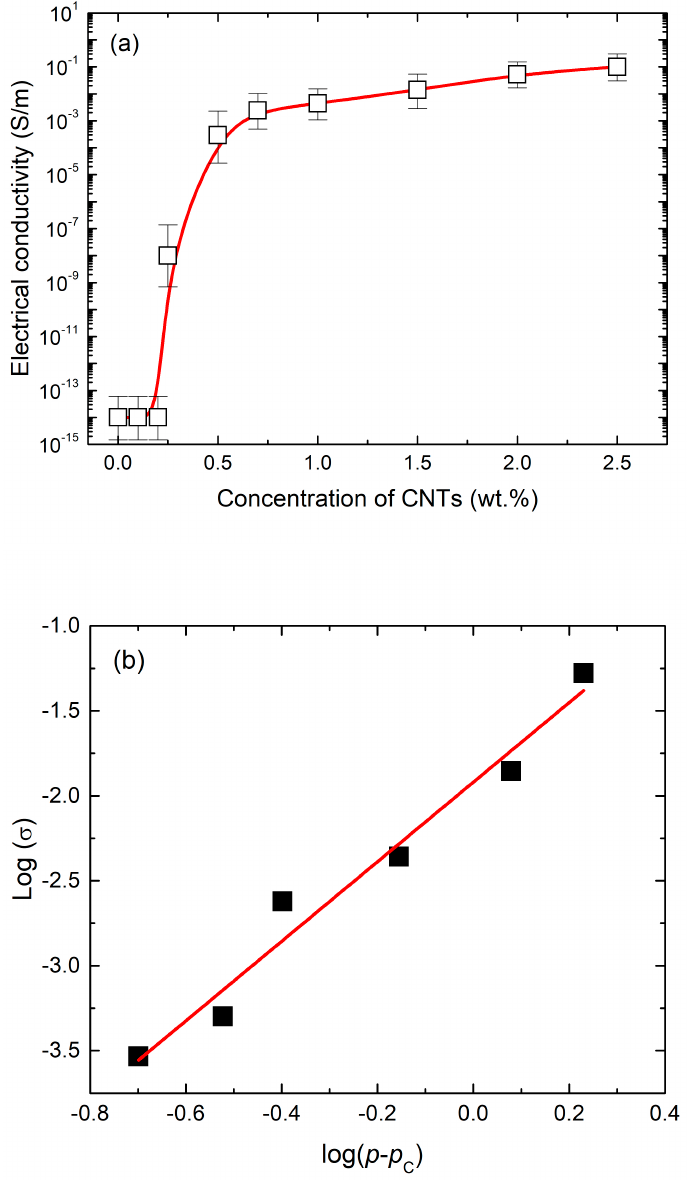
Figure 2. ( a ) Electrical conductivity and ( b ) curve fitting of CNT/epoxy composites.